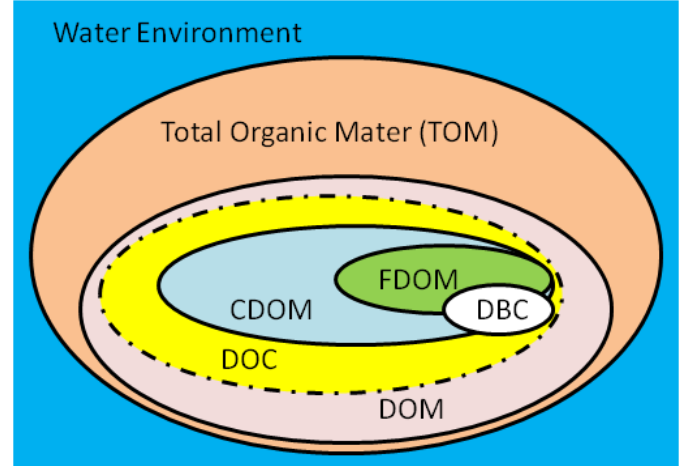
Figure 1. Schematic diagram of the main organic components in natural water (DOC is dissolved organic carbon; CDOM is colored dissolved organic matter; FDOM is fluorescent dissolved organic matter; DBC is dissolved black carbon).